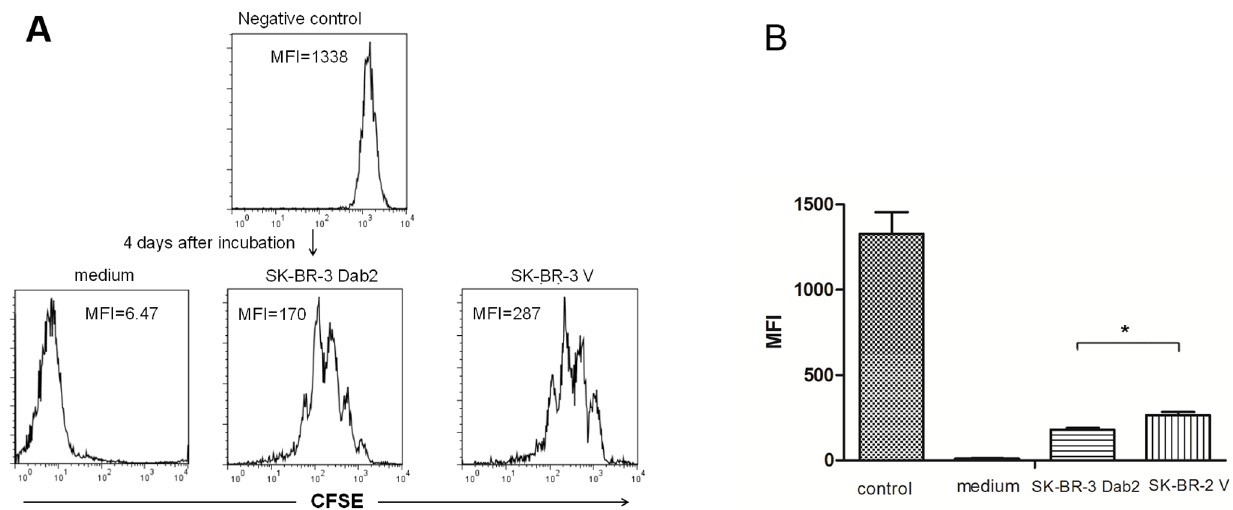
Figure 7. The inhibitory effects of Tregs induced with condition mediums from mock- or Dab2-transfected SK-BR cells on T cell proliferation. Condition medium from SK-BR-3 V cells or SK-BR-Dab2 cells were used to differentiate CD4 + CD25-naı¨ve T cells to CD4 + CD25 + Foxp3 + Tregs. The freshly differentiated Tregs were then co-cultured with CFSE-labeled CD4 + CD25- naı¨ve T cells at a ratio of 1:1 to examine the effects of Tregs on T cell proliferation. A lower mean fluorescence intensity (MFI) indicates more cells proliferation in this assay (CFSE label will be diluted 50% each time cell divides). (A) Representative data from 1 of 3 assays (medium-treated group, SK-BR-3 V medium group, and SK- BR-3 Dab2 medium group were treated with anti-CD3/CD28; negative control cells were untreated). (B) Means 6 SD of three independent experiments (MFI) in different groups (*P , 0.05).